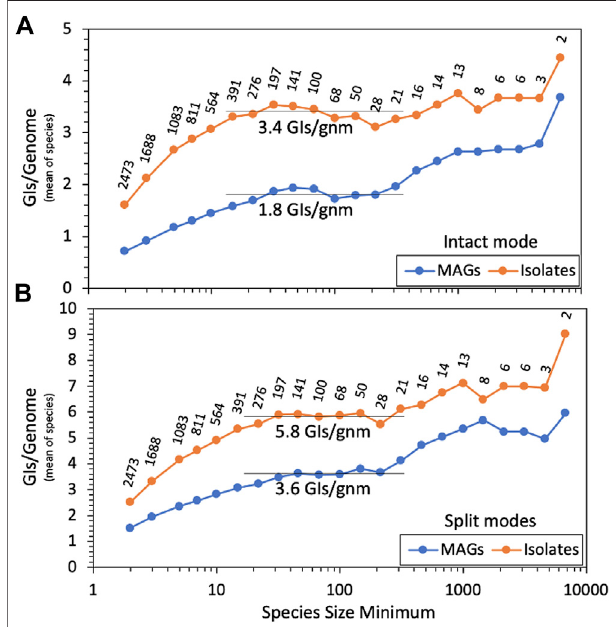
FIGURE2| GIyields forMAGs and isolate genomes.TIGER2 wasrun in (A) intact-onlymodeor (B) splitmodesongenomesfrom2473GTDBspecies containingat leastoneMAGand oneisolate genome,measuringGIs/genome withineachspecies;shownhereisthemeanoftheGI/genomevaluesfor allspeciestestedateachsize(i.e.,genomecount)cutoff.Datalabelsshowthe numbers of species remaining with each size